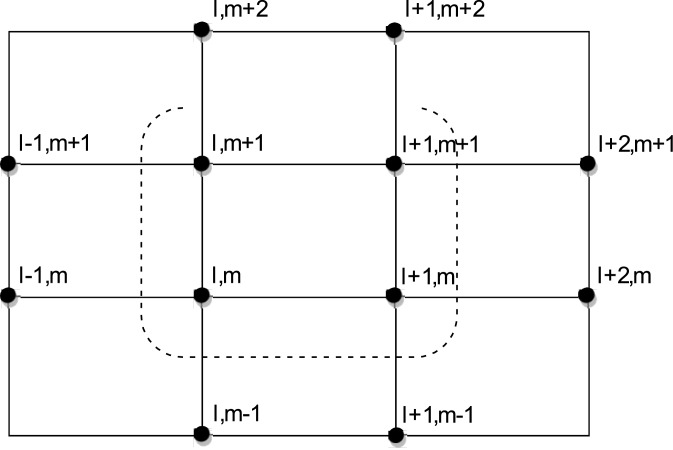
Computational Molecule of Eq (20).